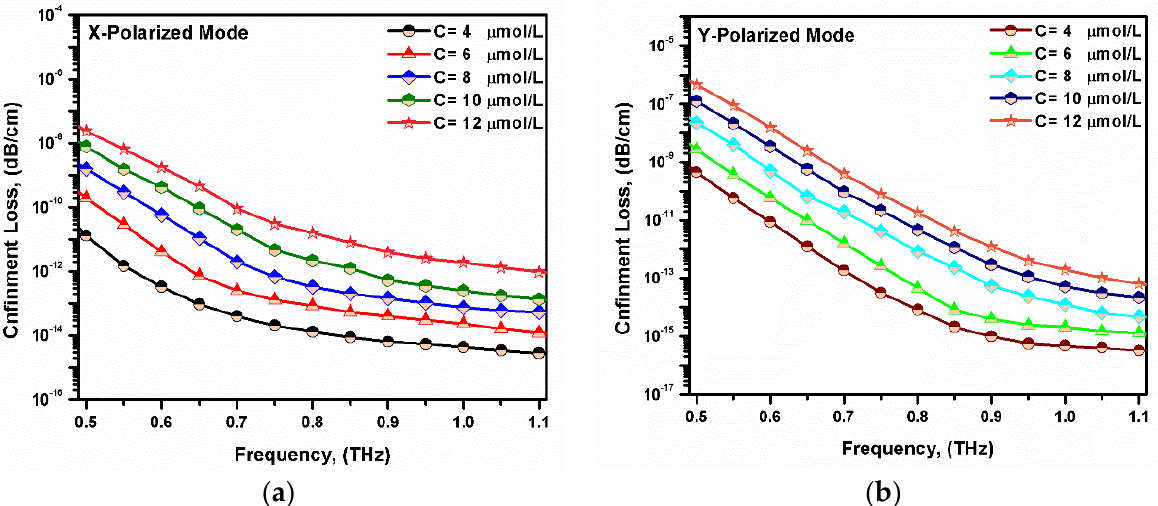
Figure 7. Variation in the confinement loss with the frequency for the fundamental ( a ) x-polarized mode and ( b ) y-polarized mode at different bilirubin concentrations.